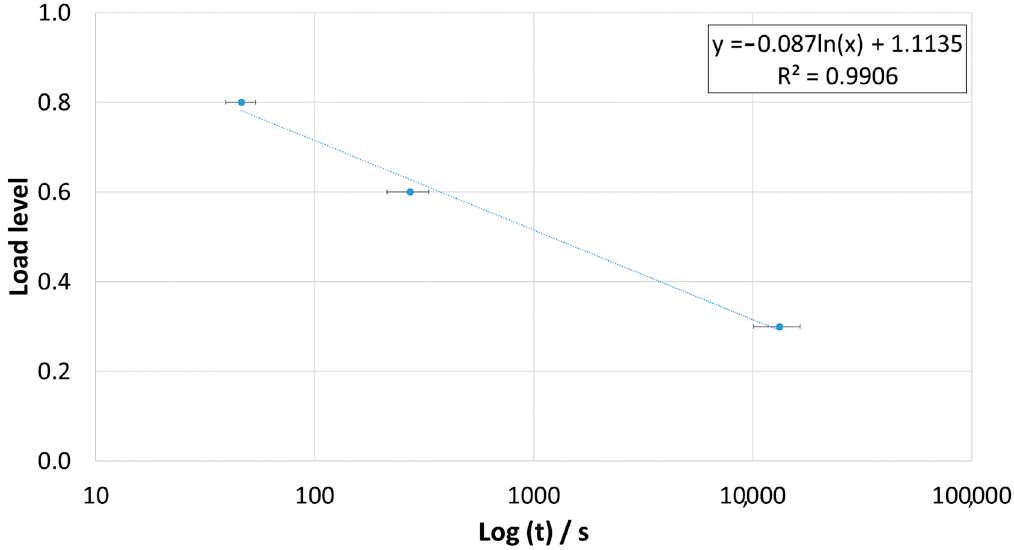
Figure 11. Time to failure (s) of the static creep tests as a function of the load level.